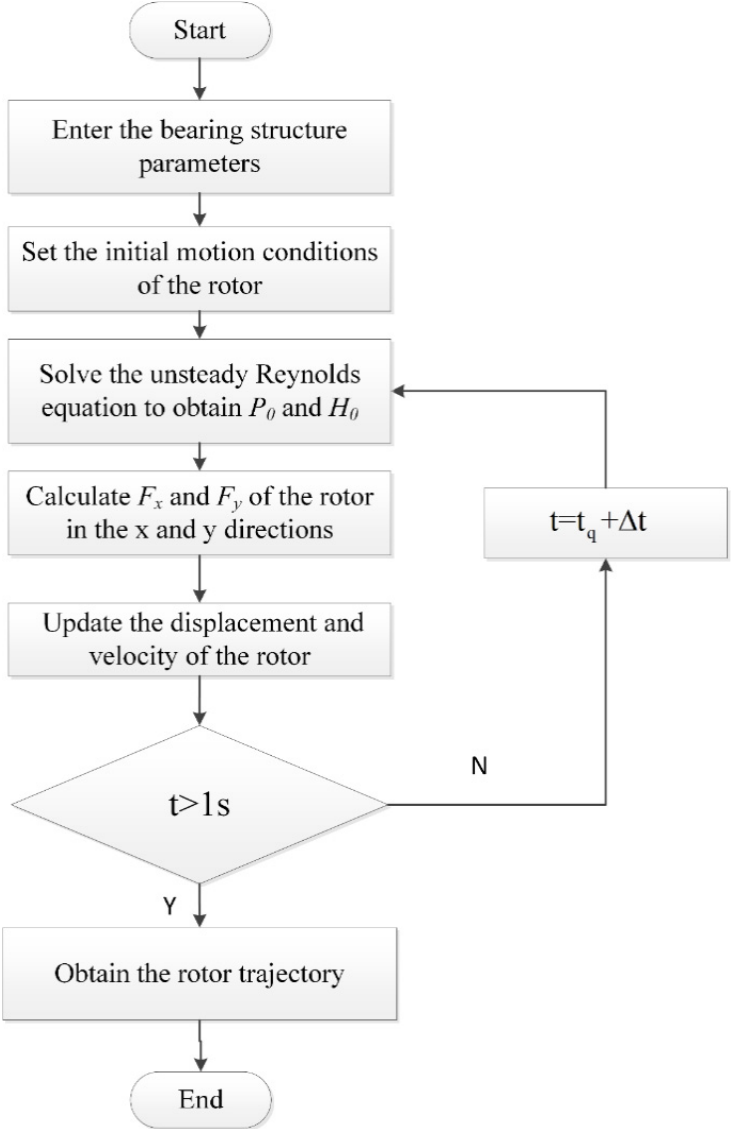
Figure 2. Flow chart of rotor trajectory calculation.